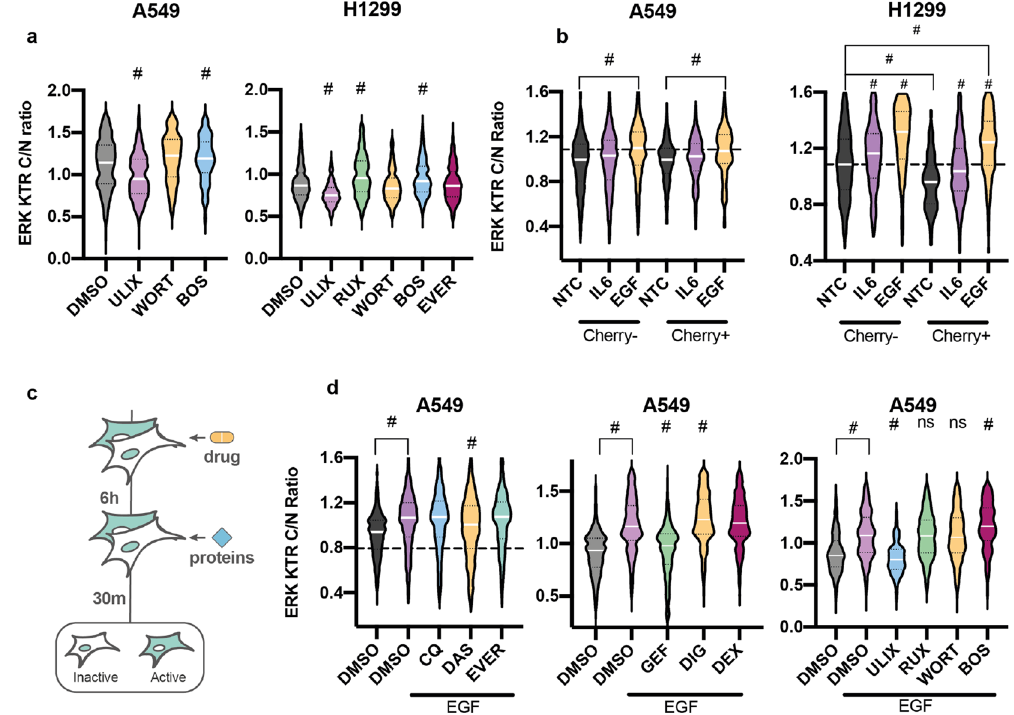
Figure 4. Drugs and proteins change the transduction efficacy of lung cells and the ERK activity. ( a ) Violin plots of ERK activity in A549 and H1299 cells measured with ERK-KTR. A549 cells were treated with 50 nM ulixertinib (ULIX), 10 µM wortmannin (WORT), 1 µM bosutinib (BOS) for 6 h. H1299 cells were treated with 50 nM ulixertinib (ULIX), 10 µM ruxolitinib (RUX), 10 µM wortmannin (WORT), 1 µM bosutinib (BOS), and 100 nM everolimus (EVER) for 6 h. p-value is calculated relative to DMSO-treated sample. ( b ) Violin plots of ERK activity in A549 and H1299 cells with ERK-KTR. Cells were incubated with lentiviral particles for 72 h and proteins were added to serum negative media 30 min before the fluorescence detection. ( c ) Scheme of the experiment: A549 and H1299 cells with ERK-KTR were treated with the drugs and proteins for 6 h in serum negative media before the addition of 100 ng/mL EGF for 30 min before fluorescence detection. ( d ) Violin plots of normalized ERK activity in A549 cells measured with ERK-KTR. Cells treated with drugs were compared to cells treated only with EGF by Mann–Whitney test. Drugs and proteins concentrations: 5 µM chloroquine, 25 nM dasatinib, 100 nM everolimus, 5 µM gefitinib (GEF), 25 nM digoxin (DIG), 10 µM dexamethasone (DEX), 50 nM ulixertinib (ULIX), 2.5 µM ruxolitinib (RUX), 10 µM wortmannin (WORT), 1 µM bosutinib (BOS), 100 ng/mL IL6 and EGF. p-value is calculated relative to DMSO + EGF treated sample unless it is marked otherwise. LVP lentiviral particles. p-value for ( a – d ) was calculated by Mann–Whitney test, # p-value <